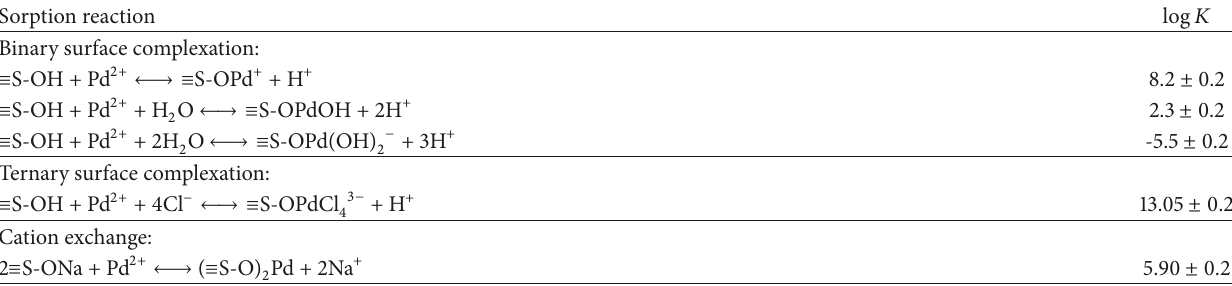
Table 2: Optimized surface complexation and cation exchange constants